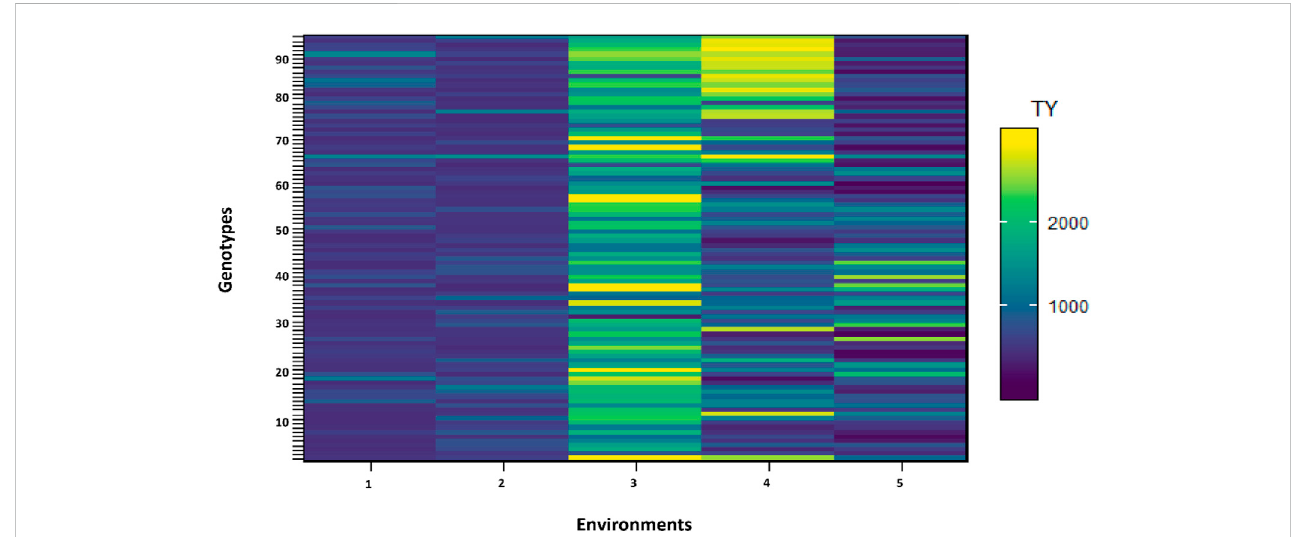
FIGURE 3 Shade plot across fi ve environments. Number of genotypes (x-axis) and environments (y-axis).